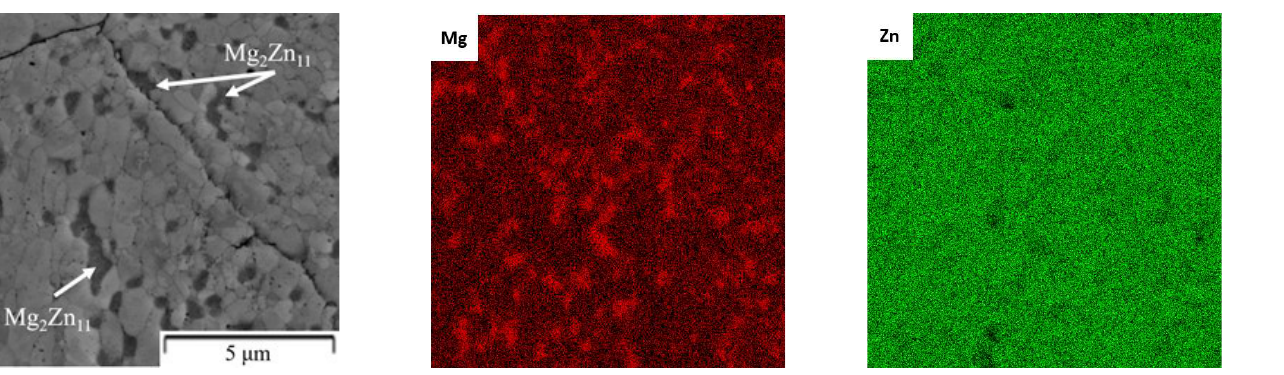
Figure 9. The distribution of elements in the Zn-1Mg alloy compacted by SPS (powder was prepared at conditions 1200 RPM, 60 min)–EDS (SEM).